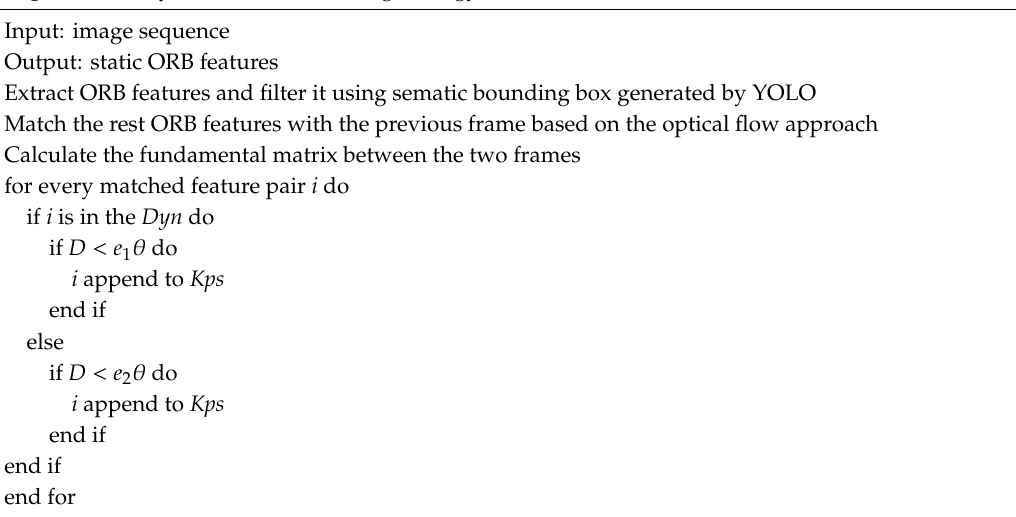
Algorithm 2. Dynamic feature-filtering